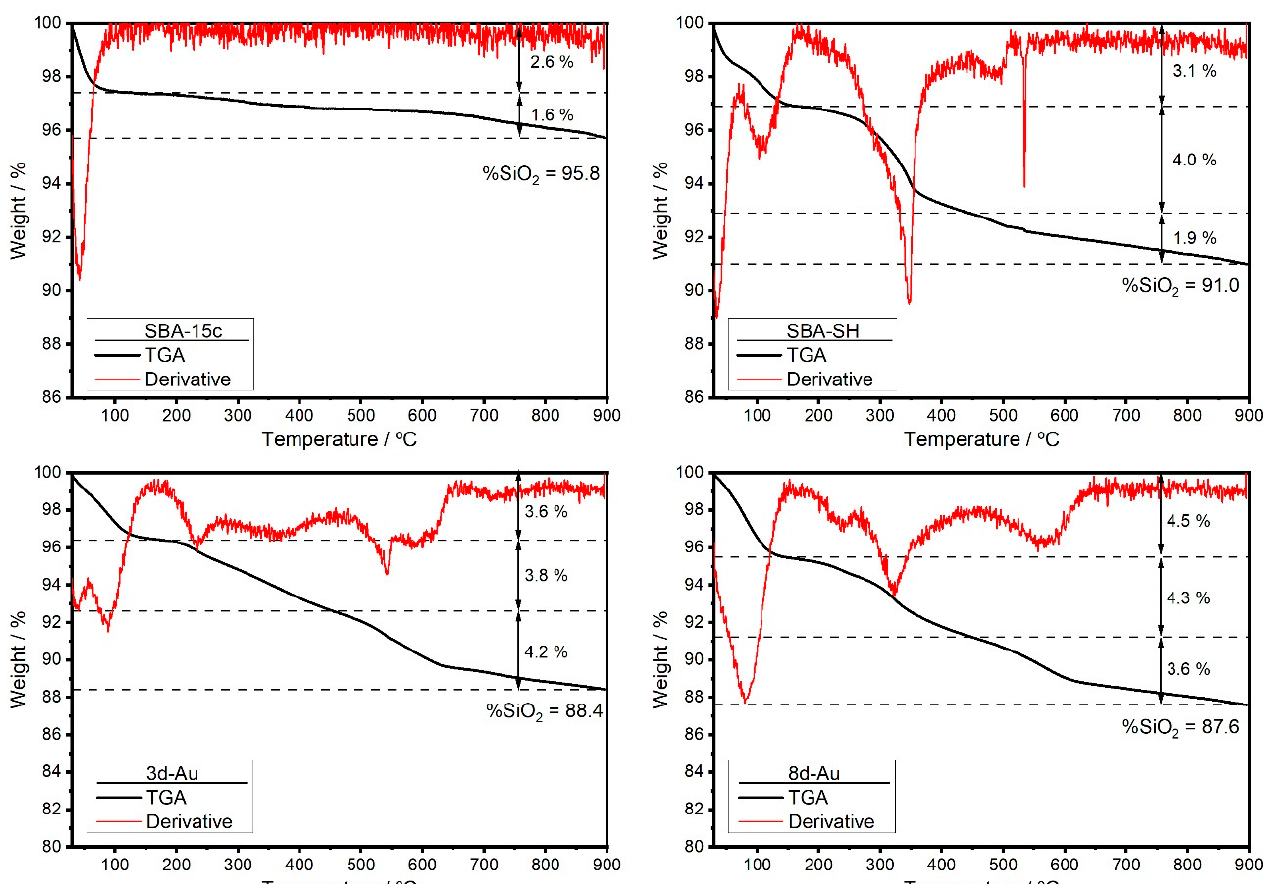
Figure 1. TGA (black line) and DTG (red line) of selected samples.